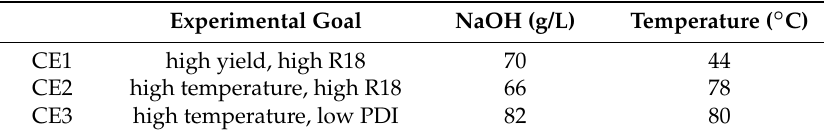
Table 1. Targets and conditions of validation